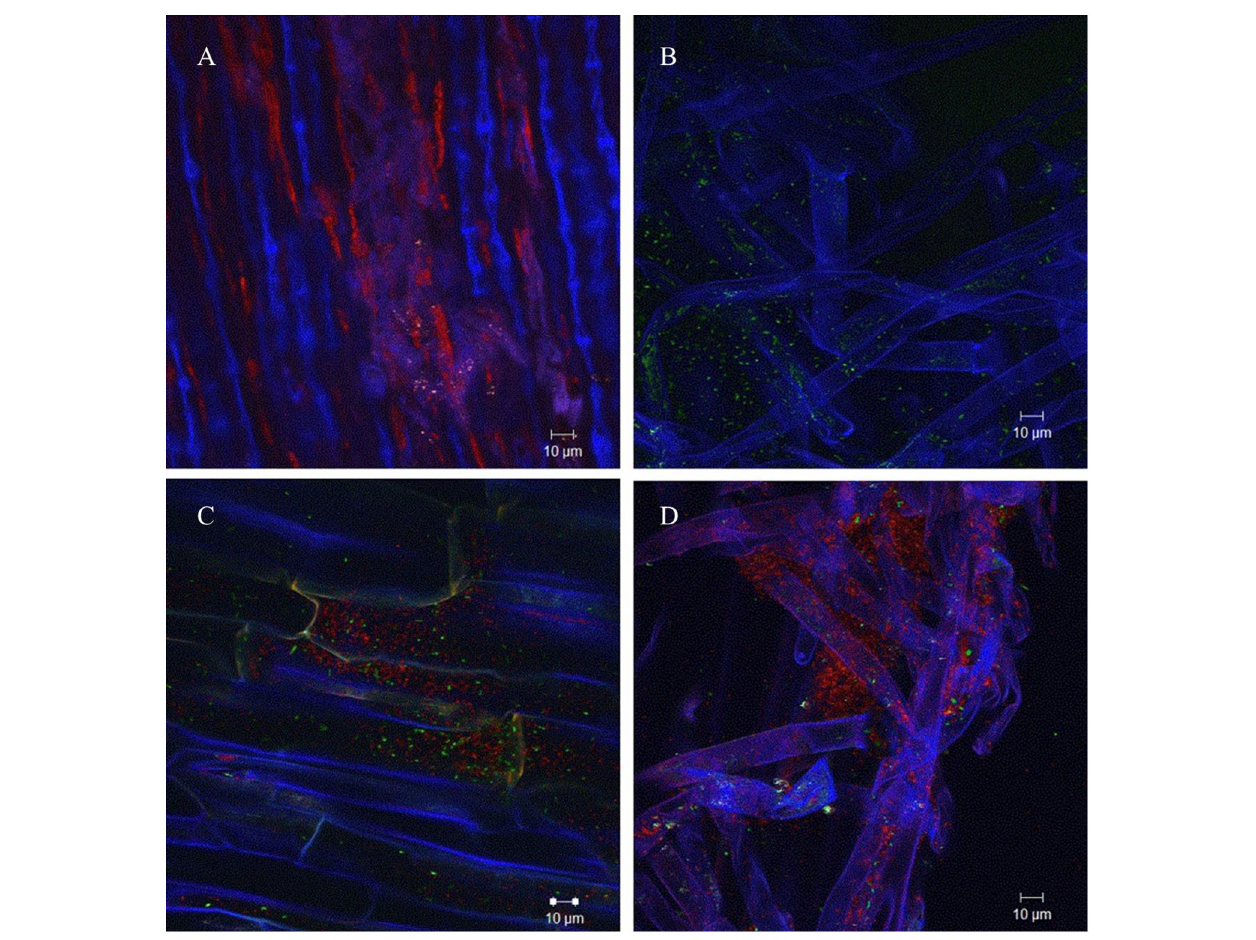
FIGURE 2 | Colonization of barley roots by fluorescence labeled A. radicis N35 wild type and araI mutant detected using CLSM lambda mode. Blue color represent barley roots, red color represent the YFP-labeled A. radicis N35 wild type and green color represents the GFP labeled A. radicis N35 araI::tet AHL mutant. (A) YFP-labeled A. radicis N35 forms biofilm in the main root part and root hair part. (B) GFP-labeled A. radicis N35 araI::tet . (C,D) Inoculation with GFP-labeled A. radicis N35 araI::tet mutant mixed 1:1 with YFP-labeled A. radicis N35 wild type.